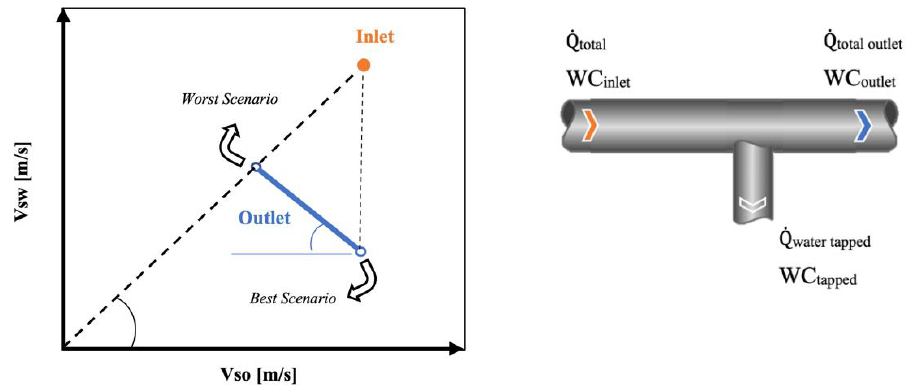
Figure 21. Separation Triangle: representation of all possible separation efficiencies for a tapped flow rate in a superficial velocity plot [5].